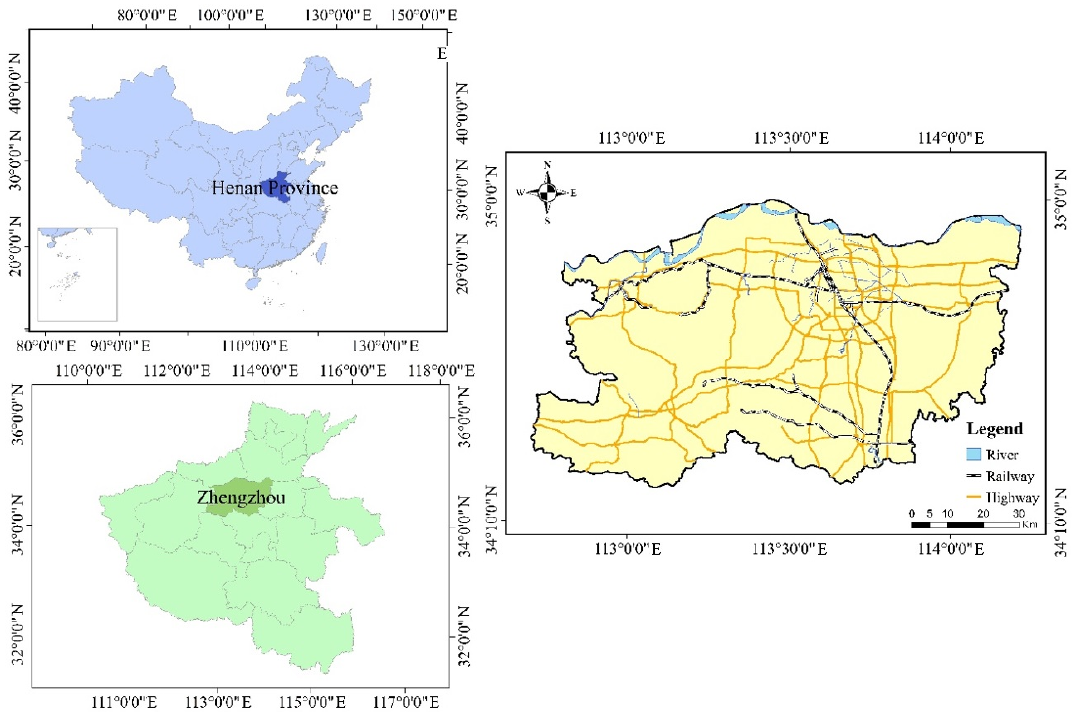
Figure 1. Location of study area in Zhengzhou, Henan, China.